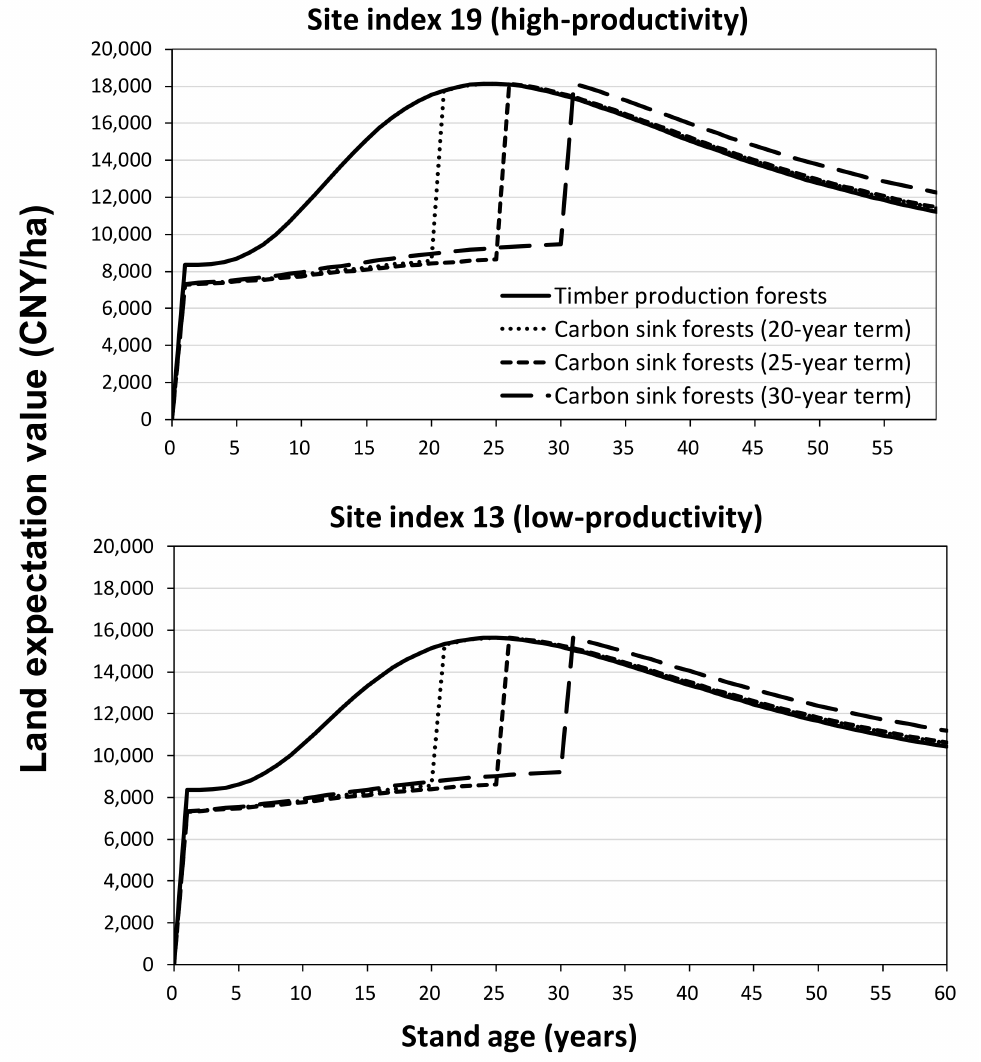
Figure 4. Land expectation values (LEVs) of larch forests for only timber production and for carbon sinks under varying carbon sink contract terms and site conditions in Gansu, Northwest China. The LEVs of carbon sink forests at the optimal rotation age were evaluated using the minimum carbon credit price required in Table 3 to break even for comparison with the maximum LEVs of timber production forests at the optimal rotation age